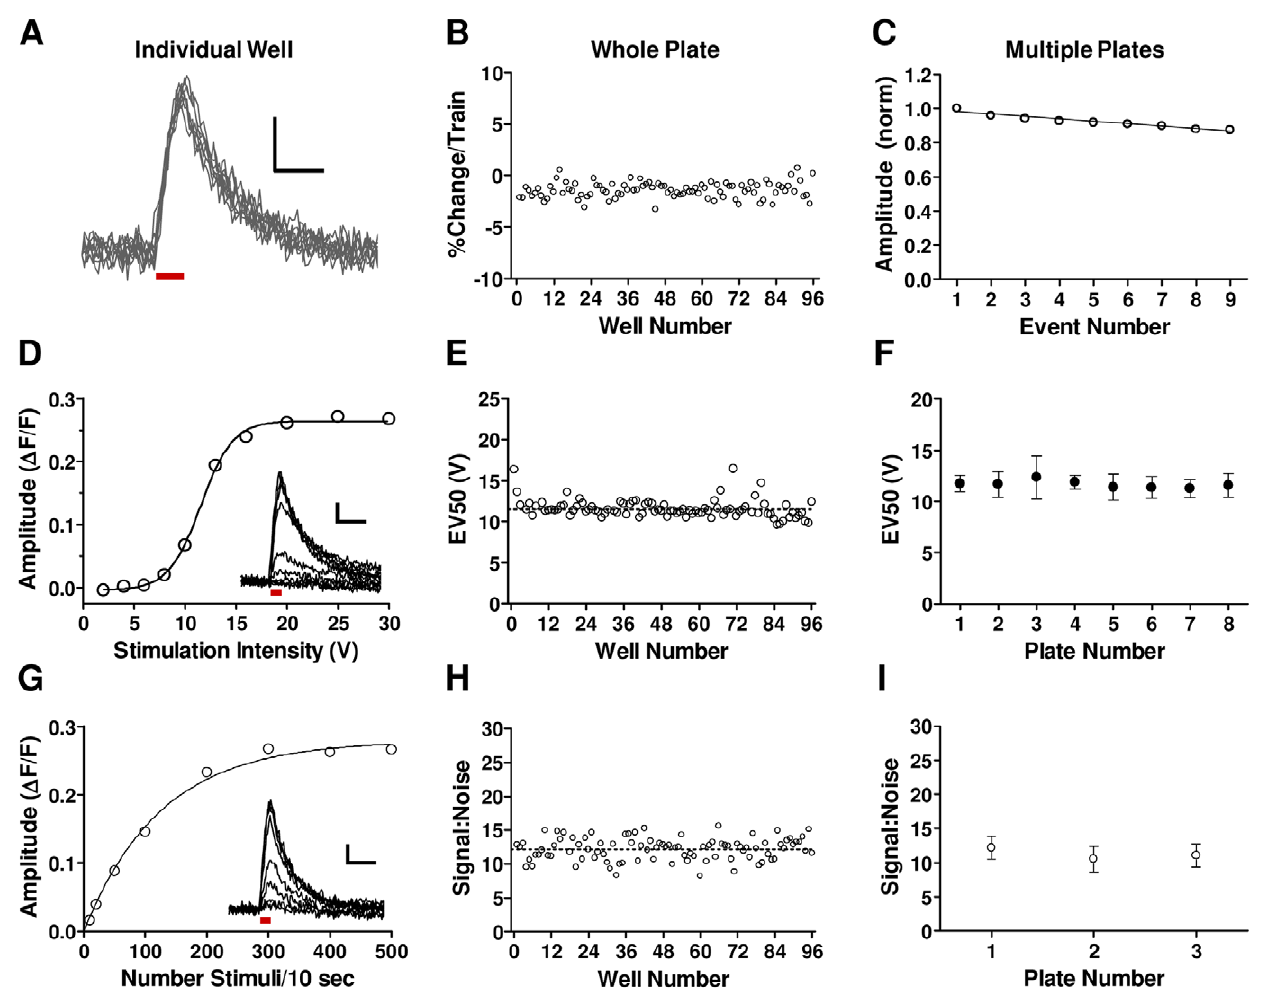
Figure 3. Validation of the MANTRA system technical performance. ( A ) Superimposed traces from nine successive 10 Hz, 10 sec trains from a single well. Bar indicates stimulus. Scale bars: 0.05 D F/F, 20 sec. ( B ) Amplitudes from all wells of a plate were calculated for the nine trains and normalized to the first train. Shown is the mean percent change per train for each well. Amplitude change per train for all wells was 2 1.5 6 0.97% (mean 6 SD). ( C ) Normalized amplitudes (mean 6 SD) to each train for three plates. Data were fit by linear regression (slope= 2 0.014; r 2 =0.93; p , 0.0001). Amplitude change per train across plates was 2 1.5 6 0.13% (mean 6 SEM; n=3). ( D ) Amplitudes of responses to 30 Hz, 10 sec trains delivered at increasing voltages from a representative well. Data were fit with a sigmoid function (R 2 =0.99). Inset: Individual traces. Scale bar: 0.05 D F/F, 30 sec. Bar indicates stimulus. ( E ) The voltage generating the 50% peak response (EV 50 ) for each well of a plate (%CV=9.8%). ( F ) The EV50 (mean 6 SD) from all wells of multiple plates stimulated as in (e). ( G ) Amplitudes from a well stimulated with 10 sec trains of increasing frequencies. Data were fit with a one-phase exponential curve (R 2 =0.99). Inset: Individual traces. Scale bar: 0.05 D F/F, 30 sec. Bar indicates the stimulation. ( H ) Signal:noise for responses to the 50 pulse train (mean 6 SD: 12.2 6 1.7) for a plate. ‘‘Signal’’ is amplitude. ‘‘Noise’’ is the standard deviation of a 10 second baseline. ( I ) Signal:noise (mean 6 SD) data generated from a 50 pulse train from three plates.